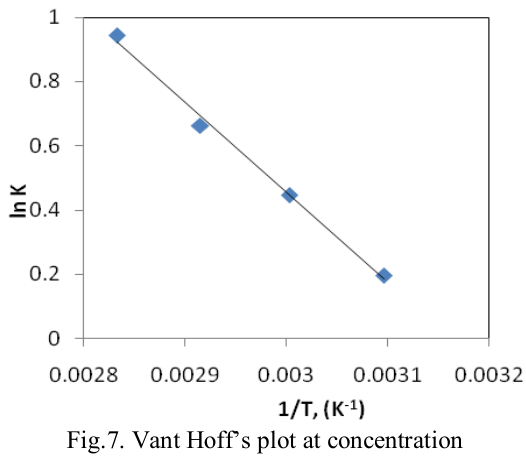
Fig.7. Vant Hoff’s plot at concentration of 10 mg/l, pH 5.0.